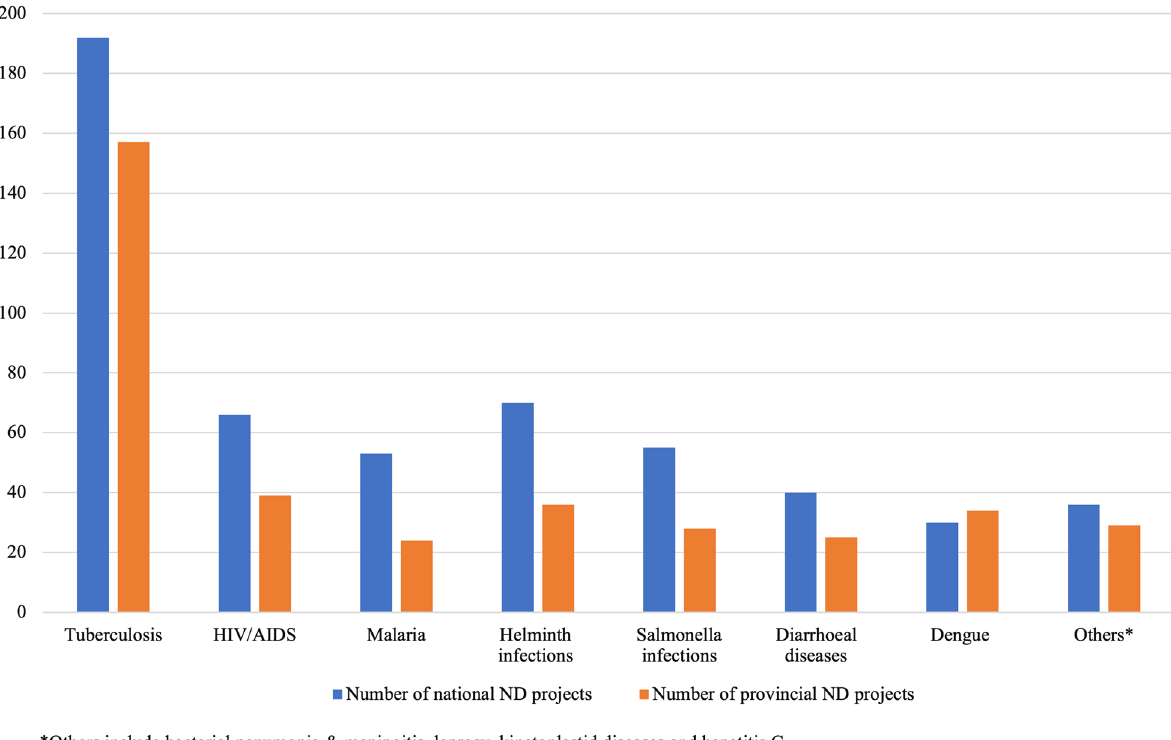
Fig. 3 Total number of 2017–2019 national and provincial ND projects by disease type